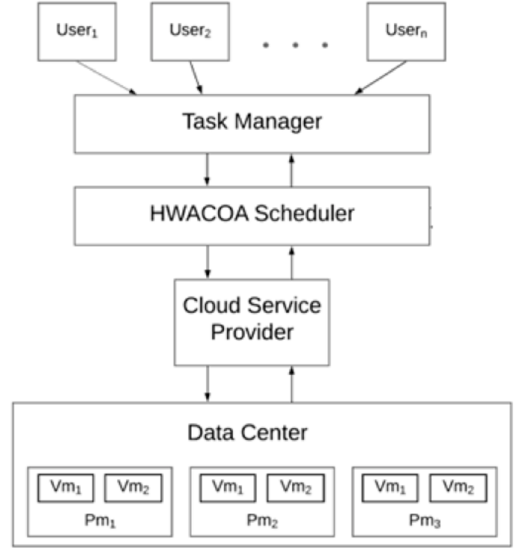
Figure 1. Architectural diagram of the task scheduler in cloud environment.